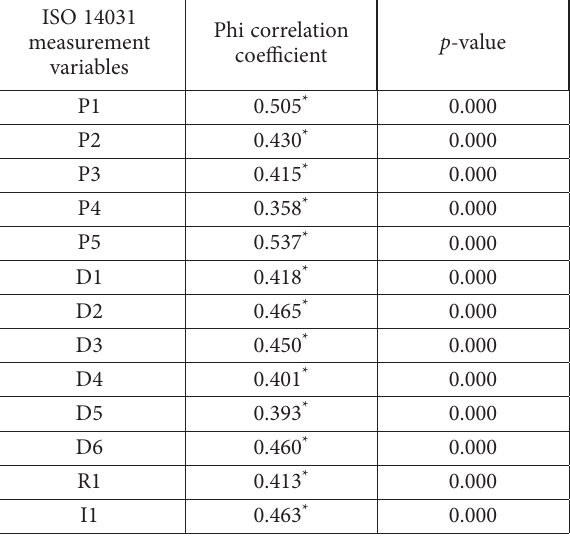
Table 4. Phi correlation coefficients between ISO 14001